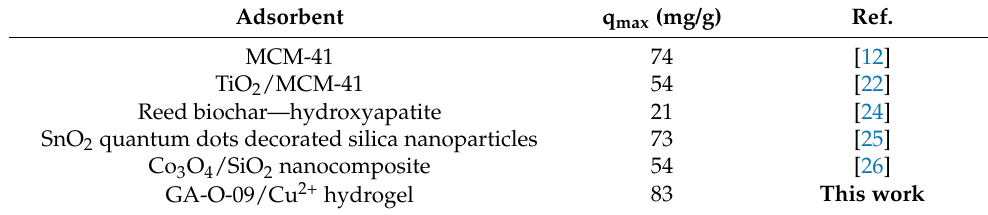
Table 2. Comparison of adsorption capabilities of GA-O-09/Cu 2+ hydrogel at room temperature with other adsorbents for MB.